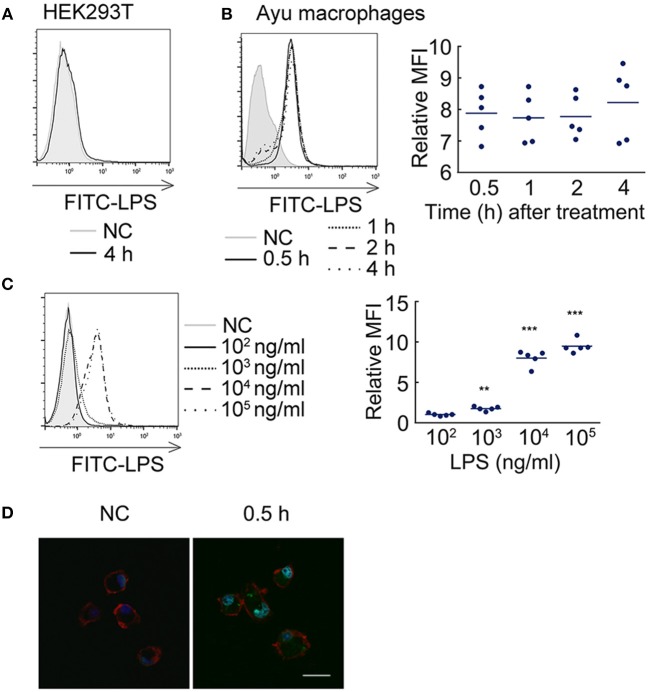
LPS internalization in ayu macrophages. (A) LPS did not enter HEK293T cells after 4 h incubation with 10 μg/ml LPS. (B) LPS detection in ayu macrophages after LPS treatment at different time points. The LPS concentration was 10 μg/ml. (C) LPS detection in ayu macrophages after LPS treatment for 4 h at different LPS concentrations. (D) Internalization of LPS in ayu macrophages was observed by confocal microscopy. Green color: FITC-LPS, red color: rhodamine-phalloidin, blue color: 4', 6'-diamidino-2-phenylindole (DAPI). Bar, 20 μm. Each bar represents the mean ± SE. n = 5. Data are representative of two (A–C) and three (D) independent experiments. **P < 0.01, ***P < 0.001.